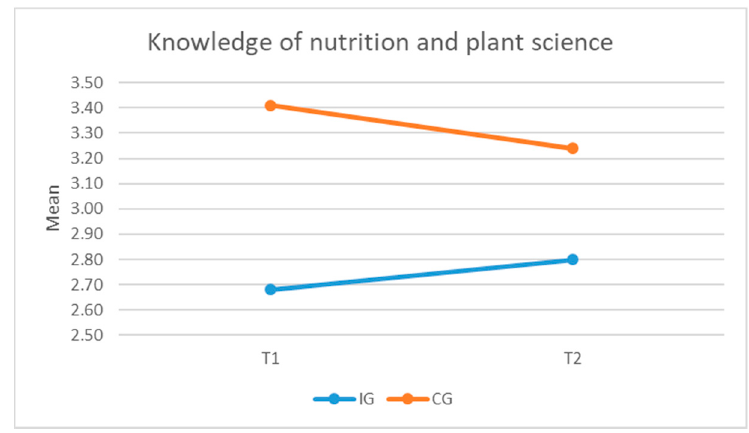
Figure 11. Di ff erence in children’s knowledge of nutrition between groups, before and after Figure 11. Difference in children’s knowledge of nutrition between groups, before and after